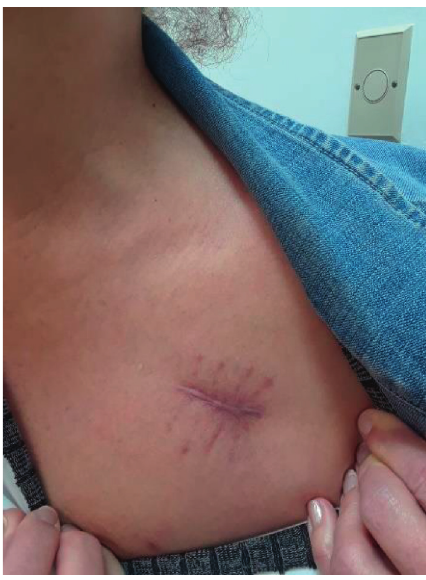
Figure 3: Pacemaker pocket site 2 months after the removal of pacemaker and antibiotic therapy. Table 1: Antibiotic susceptibility and interpretation of M. peregrinum